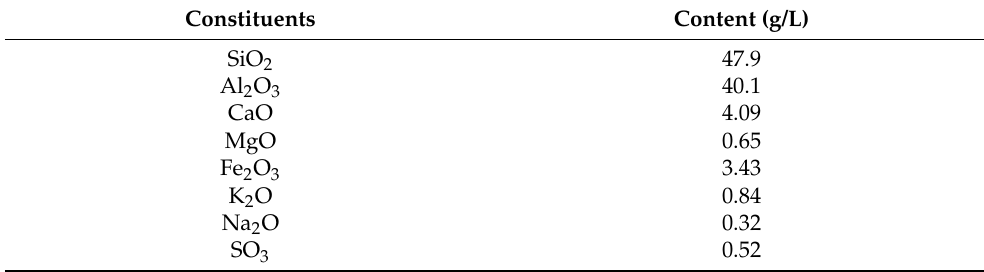
Table 1. Chemical composition of fly